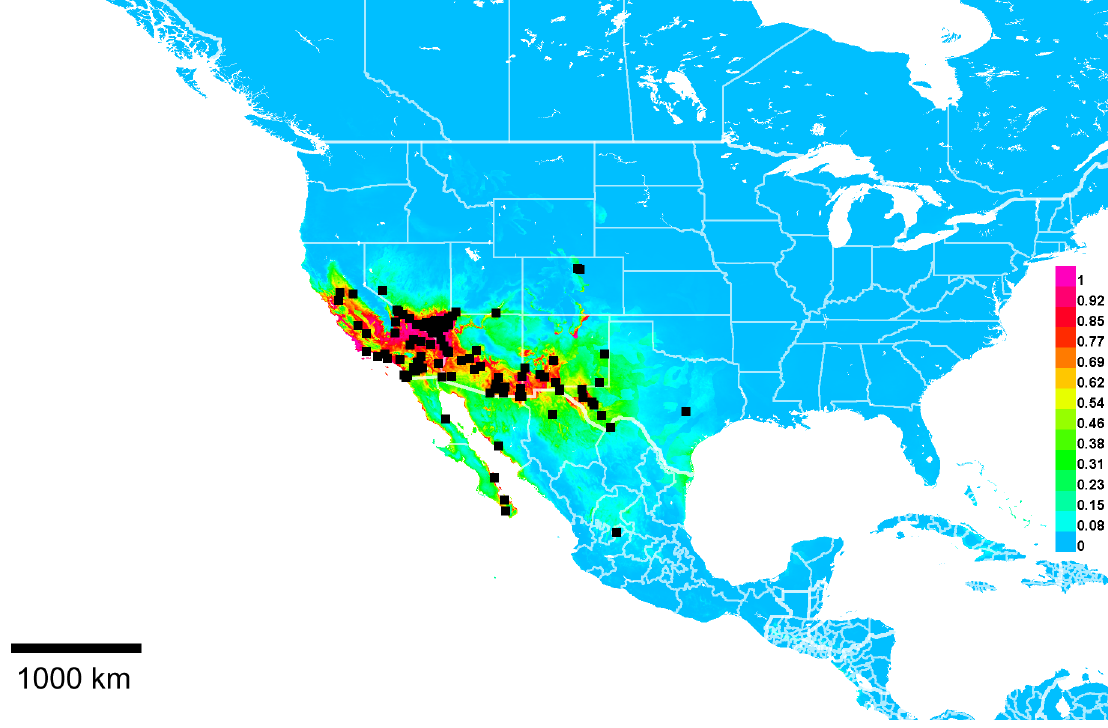
Fig. 26. Georeferenced collection records of Lasioglossum ( D .) gaudiale (Sandhouse, 1924) (black squares) and predicted distribution by maximum entropy ecological niche modelling in Maxent (colour shading). Warmer colours indicate higher cloglog probability of